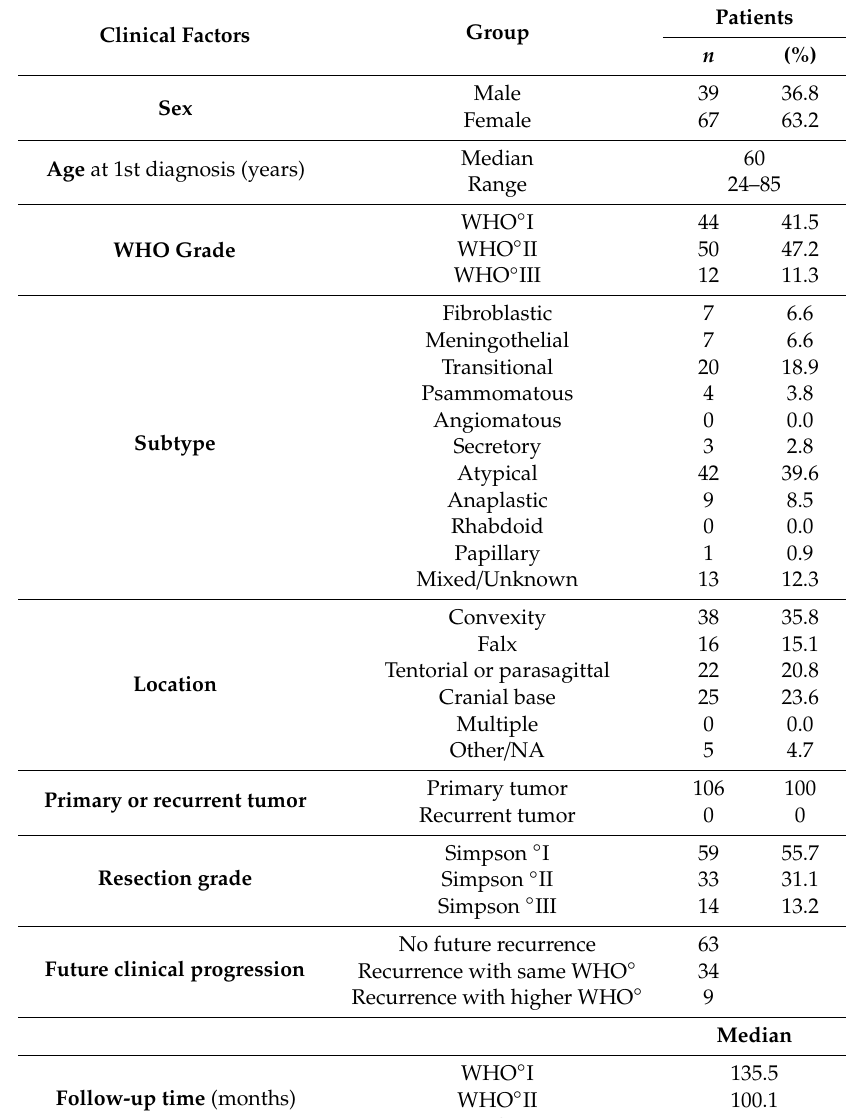
Table 2. Clinical characteristics of untreated primary meningioma patients used for the survival analyses ( n =